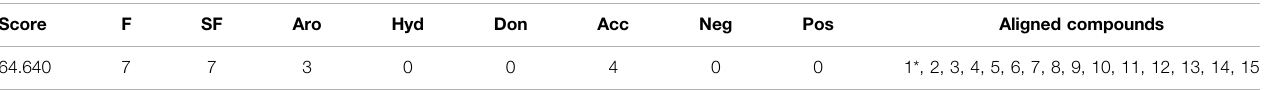
TABLE 4 | Score, pharmacophoric features, and aligned compounds in the best pharmacophore model generated by PharmaGist.